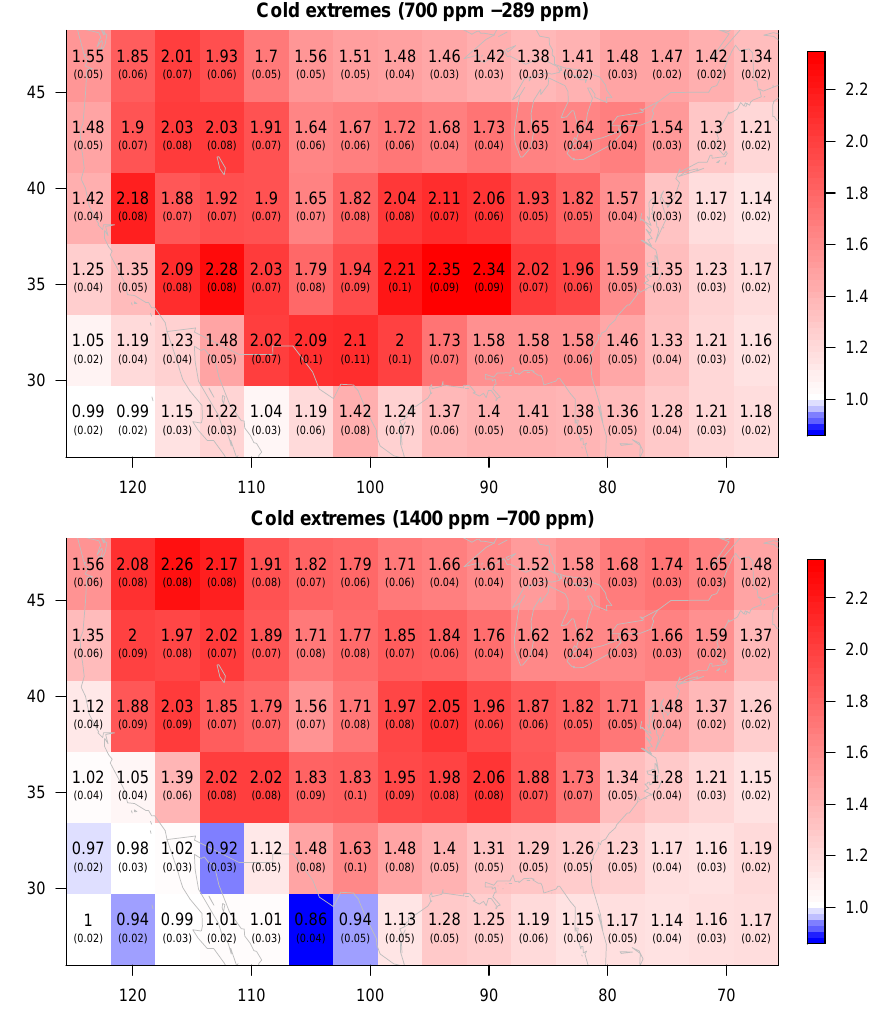
Figure E2. As in Fig. E1 but for changes in the location parameter of cold extremes to changes in winter means. These ratios are substantially greater than 1 nearly everywhere in the contiguous United